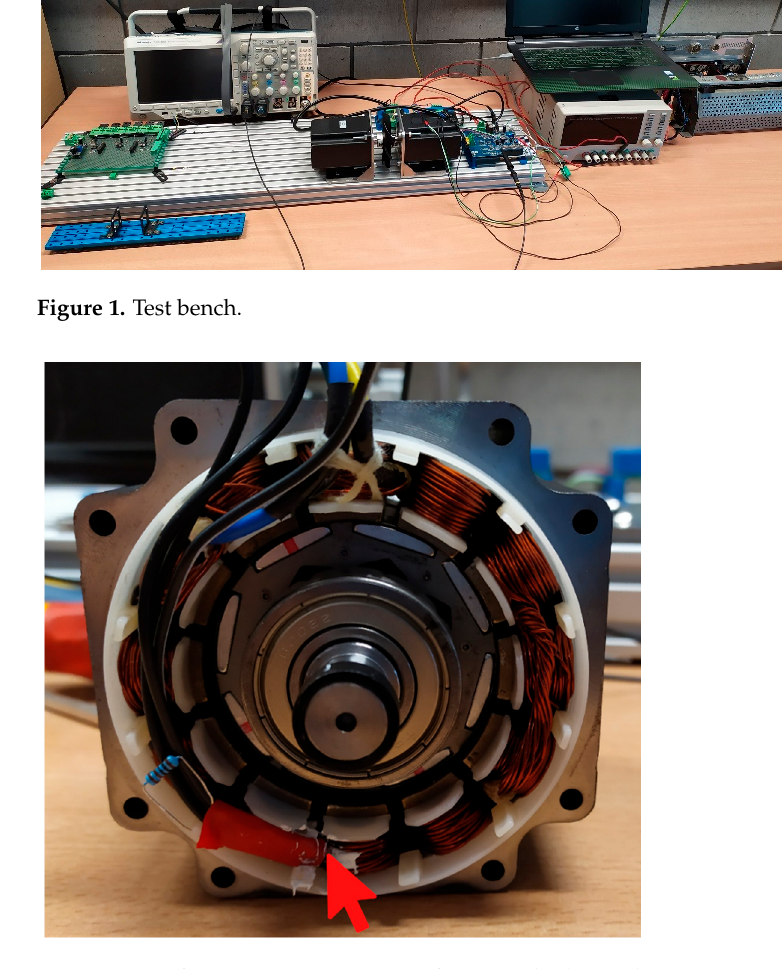
Figure 3. Placement of the cooling fan ( blue arrow ) and the casing temperature sensor ( green ar- row ).